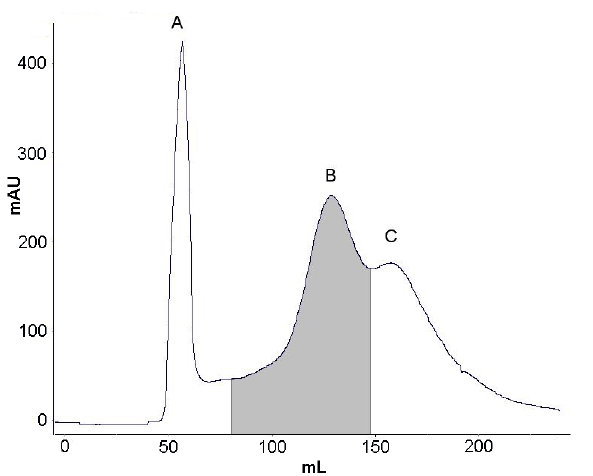
Figure 2 . The fractions under peak A in the anion- exchange chromatography were pooled and fractionated by gel filtration chromatography at a flow rate of 30 mL/hour. Peak B exhibited hemolytic